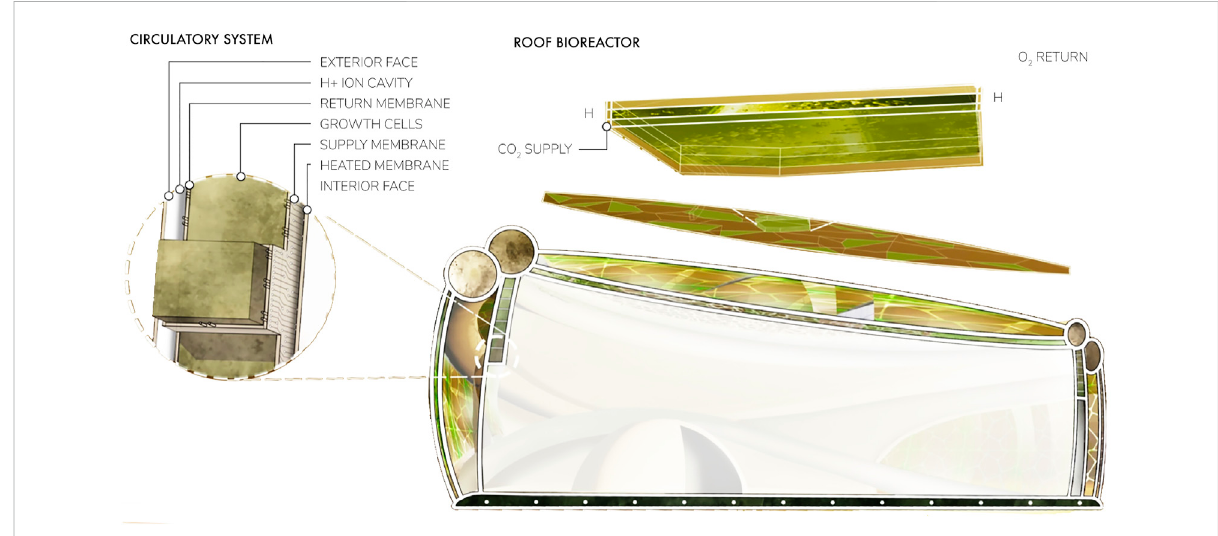
FIGURE 1 Habitat acting as an integral bioreactor, redhouse